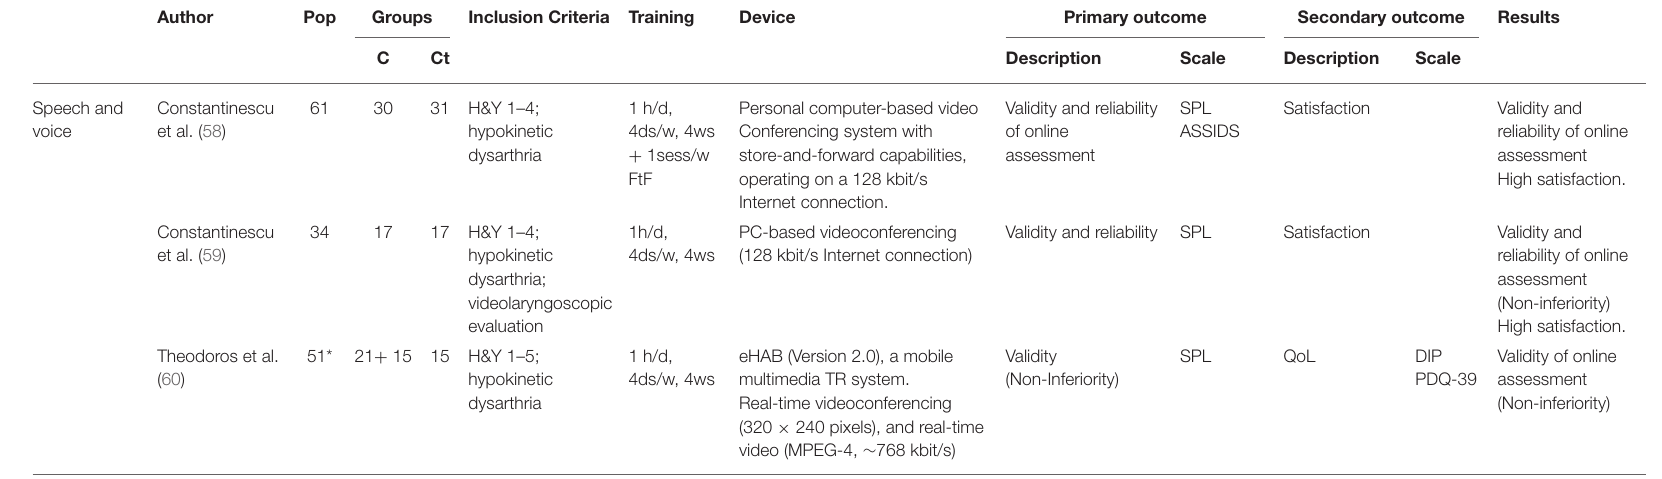
TABLE 7A | Description of the articles included which have “Speech and Voice” as primary outcome.